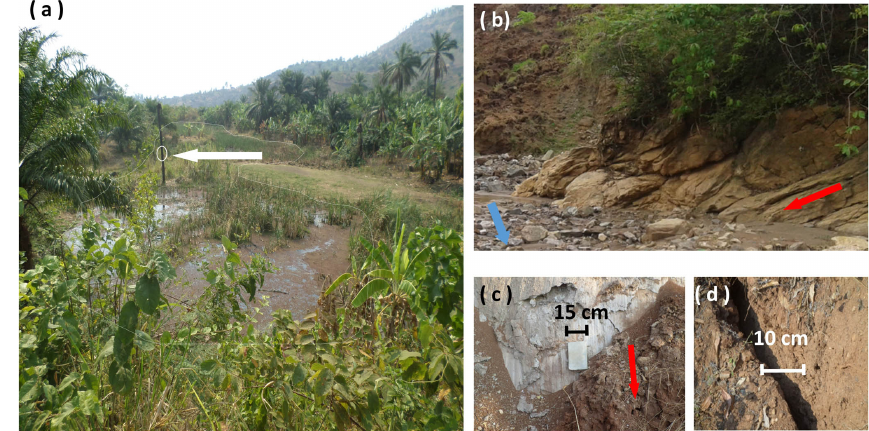
Figure 2. Field observations highlighting the critical stability state of BTL. (a) Pond on the landslide with an oil palm designated by the white arrow. This shows that these ponds are recent (oil palm trees do not grow in water; its particular foliage compared to others shows that its growth was stopped recently). (b) View of the rock structures at the foot of the landslide, generally dipping towards the north (left side), parallel to the sliding direction (red arrow). The blue arrow indicates the river flow direction. (c) View of a crack on the sliding interface in a clay layer. The red arrow shows the direction of sliding of the right part along the clay layer. (d) A crack found on the landslide